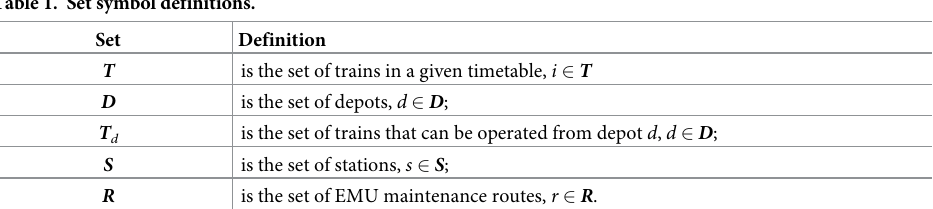
Table 1. Set symbol definitions.